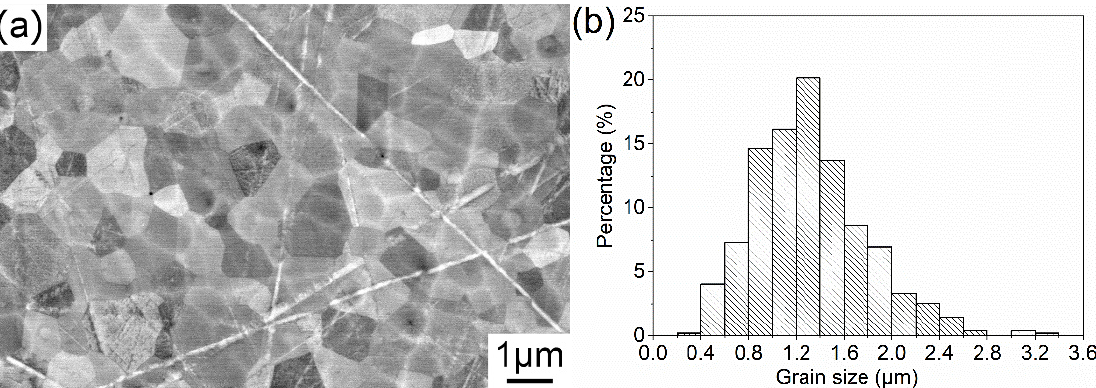
Figure 6. FESEM micrograph of the surface of Tb 2 O 3 ceramics ( a ) and the grain size distribution ( b ). Magneto-optical materials with a large Verdet constant can be realized through con- taining a high intrinsic concentration of magnetically active rare-earth ions such as Dy 3+ , Tb 3+ and Ho 3+ , which are paramagnetic and possess large magnetic moments because of the electronic transition 4 f n → 4 f n − 1 5 d . A Van Vleck–Hebb equation is usually applied to fig- ure out the Verdet constant of rare-earth ions doped materials [7,9,57]